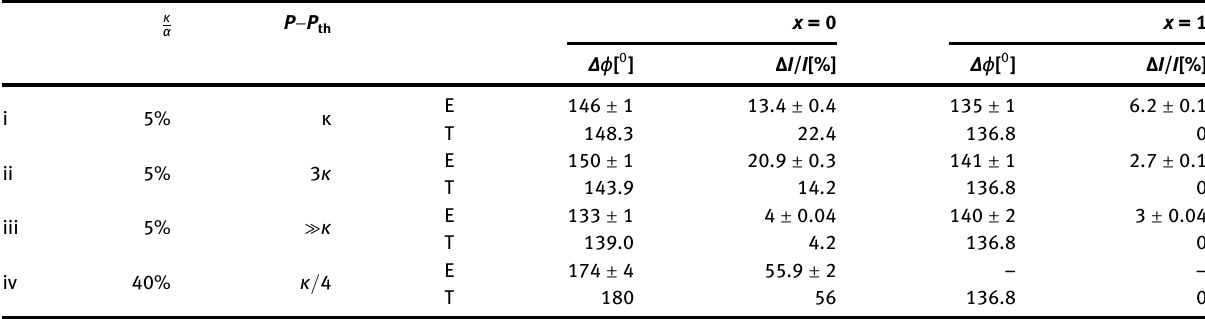
Table  : Experimental and theoretical results summary for all measured cases for identical oscillator network ( x =  ) and equal amplitude ( x =  ) states. E and T denote experimental and theoretical results,